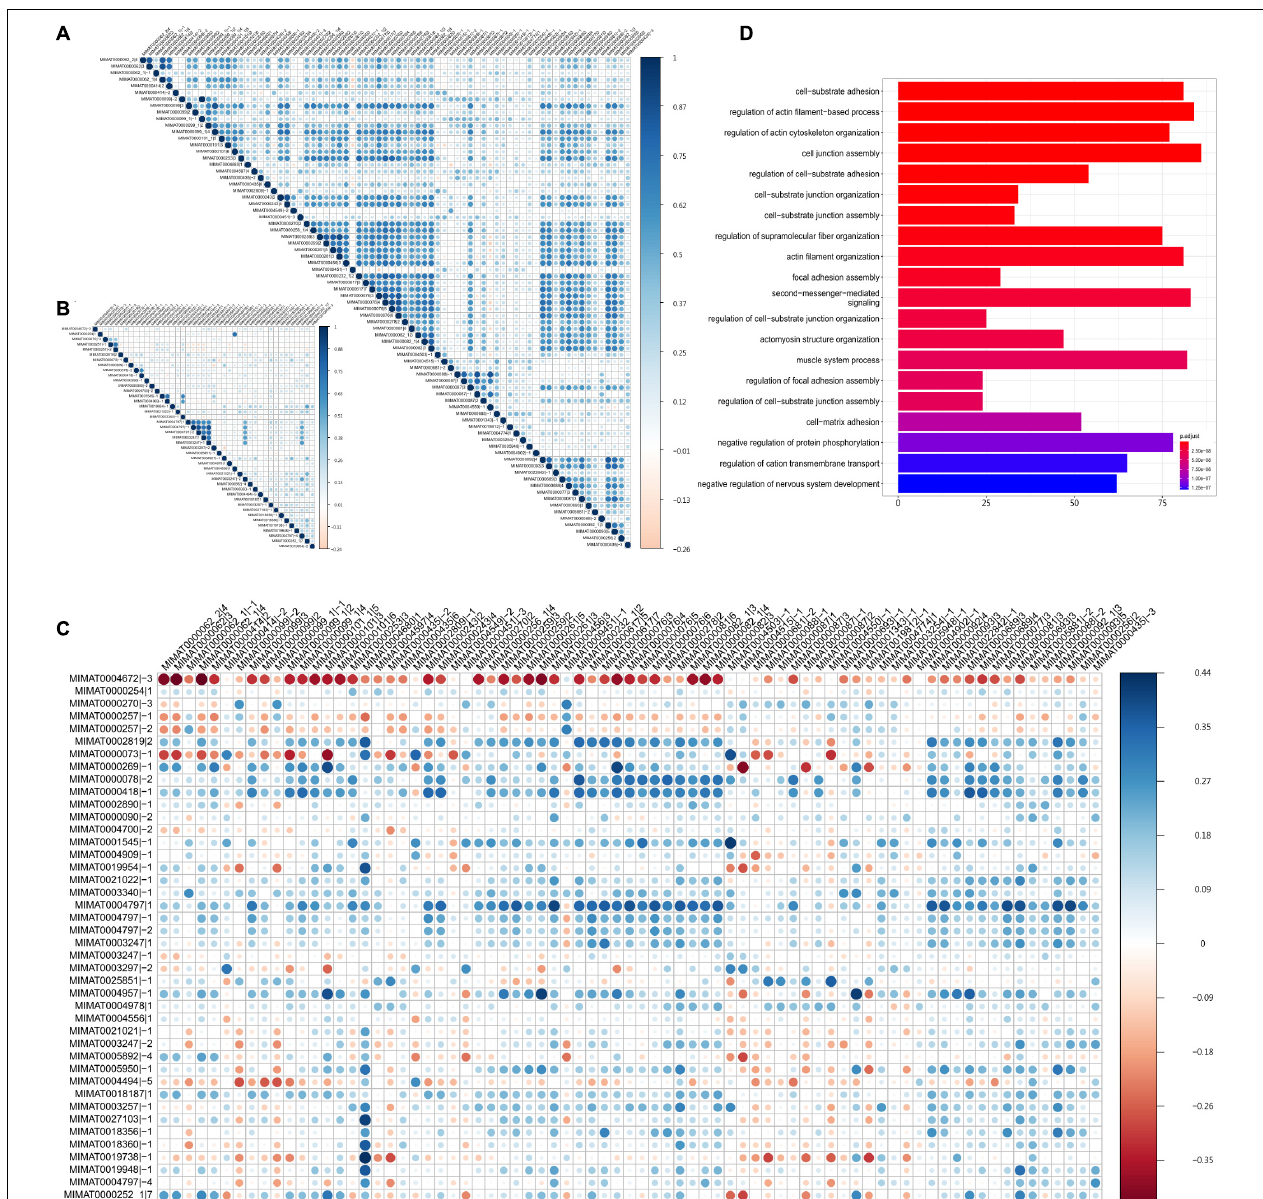
FIGURE 3 | The cooperativity between survival influential isomiRs. The Spearman’s correlation between (A) the 75 protective isomiRs, (B) the 43 harmful isomiRs, and (C) the 75 protective and the 43 harmful isomiRs. (D) The top 20 significantly enriched functions regulated by the 39 highly co-expressed and upregulated protective